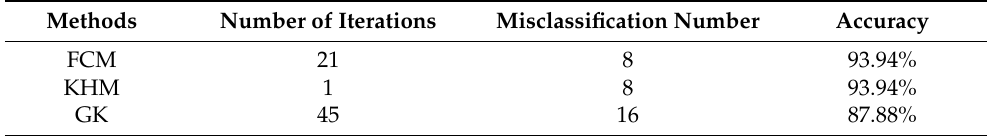
Table 1. The clustering results of FCM, KHM, and GK without pre-processing. Methods